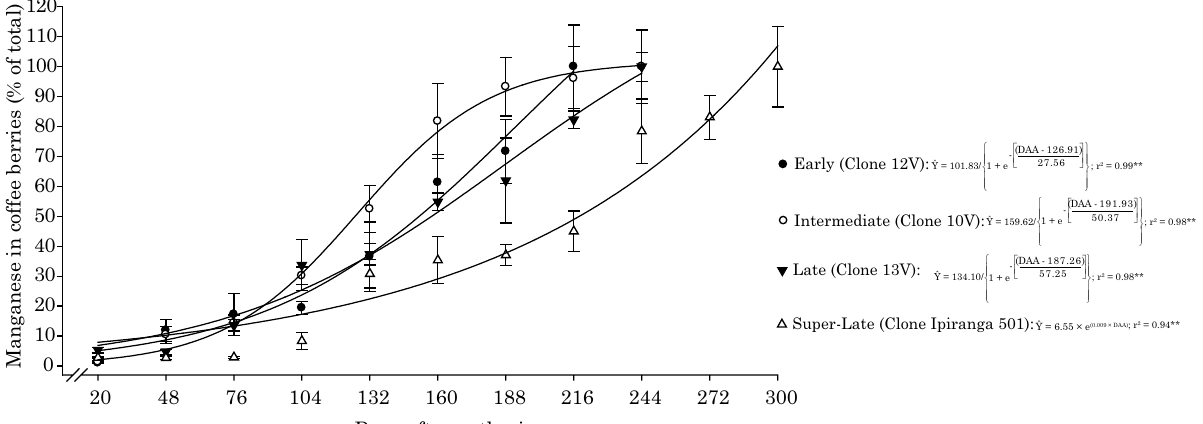
figure 3. Manganese accumulation in coffee berries (as a percentage of total accumulation) of four genotypes (clones) of ‘conilon’ coffee, from anthesis to fruit maturation. Bars represent standard deviation of the mean. **: significant at 1